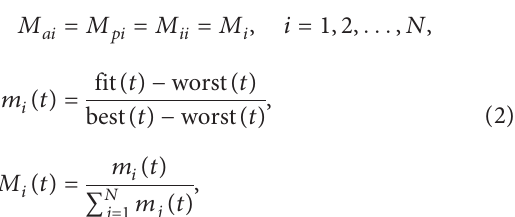
Figure 1: Process of making geopolymer concrete. (a) Raw materials for experiment. (b) Coal gangue-based geopolymer concrete. (c) Curing.